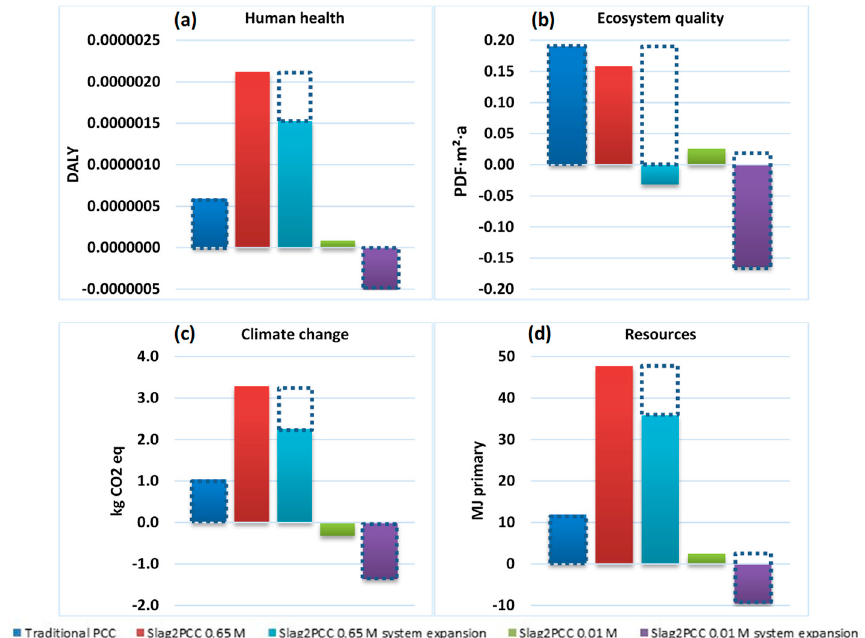
Figure 11. System boundaries for PCC production using traditional processing (red striped line box) and the use of the slag2PCC concept (blue striped line box).